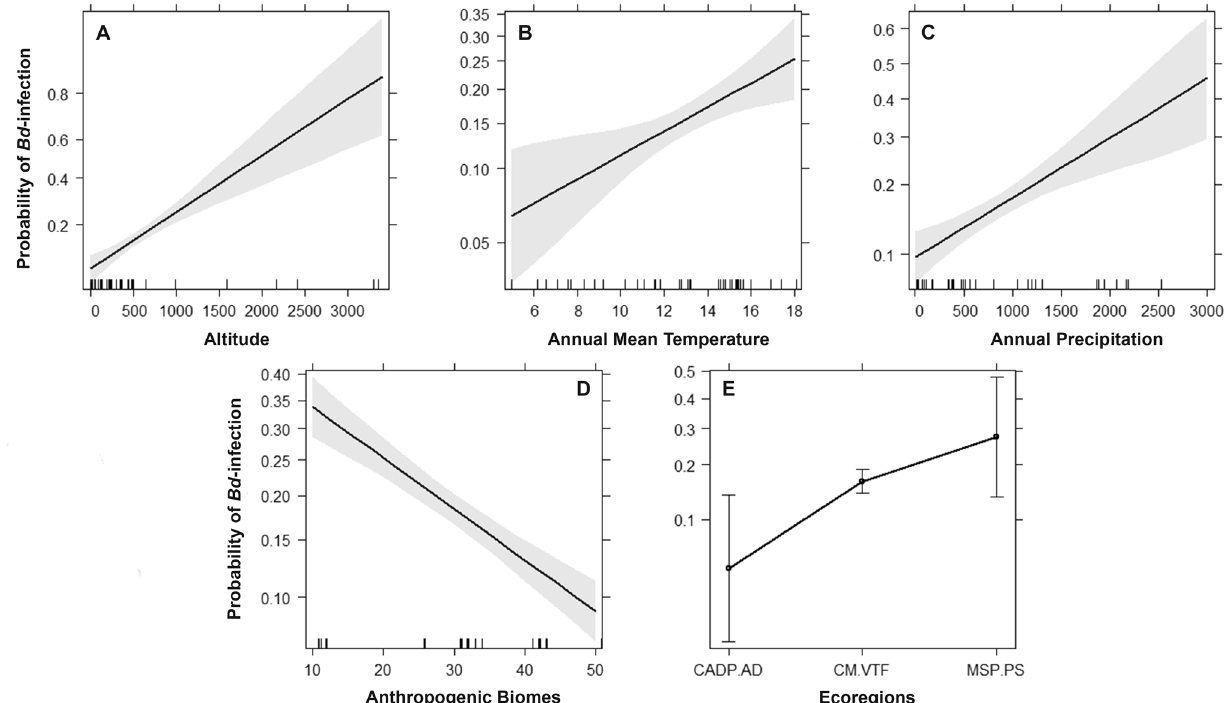
Figure 3. Best fit generalized linear model for Batrachochytrium dendrobatidis (Bd) prevalence in Chile: Bd prevalence ~ altitude + annual mean temperature + annual precipitation + anthropogenic biomes + ecoregion. Separate effects of ( A ) altitude, ( B ) annual mean temperature, ( C ) annual precipitation, ( D ) anthropogenic biomes and ( E ) ecoregions are shown. Line was draw using estimates from best supported generalized linear model. Grey shading is 95% confidence intervals. Hash marks in the x-axis represents measured values. Abbreviations in ( E ), CADP.AD = Chilean Andean dry puna + Atacama Desert, CM.VTF = Chilean